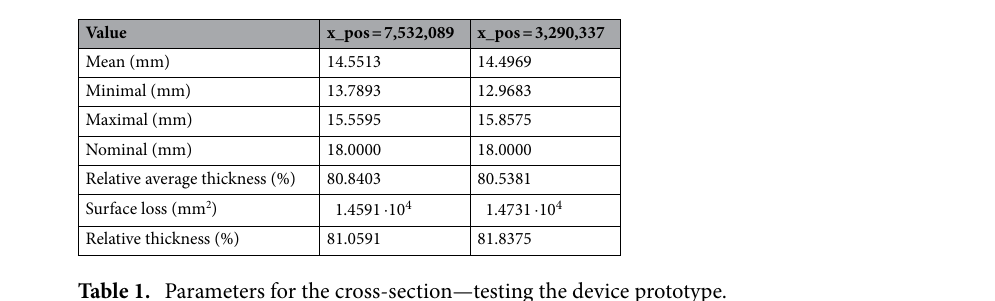
Table 1. Parameters for the cross-section—testing the device